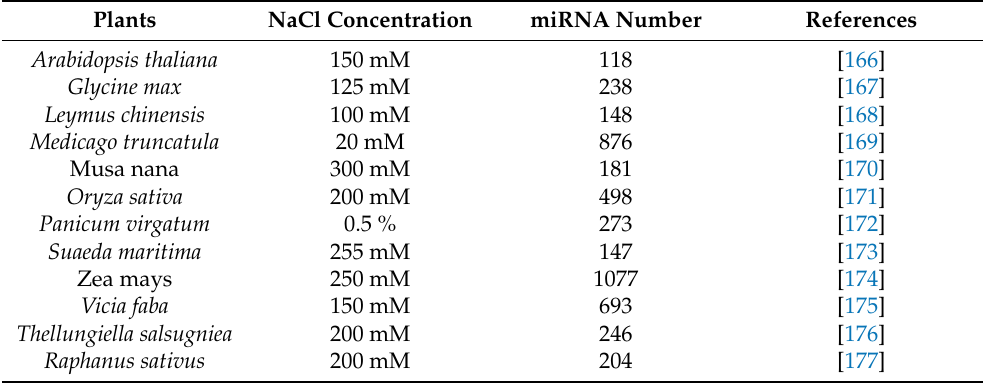
Table 6. Numbers of salt-responsive miRNAs identified under salt stress at varying concentrations of